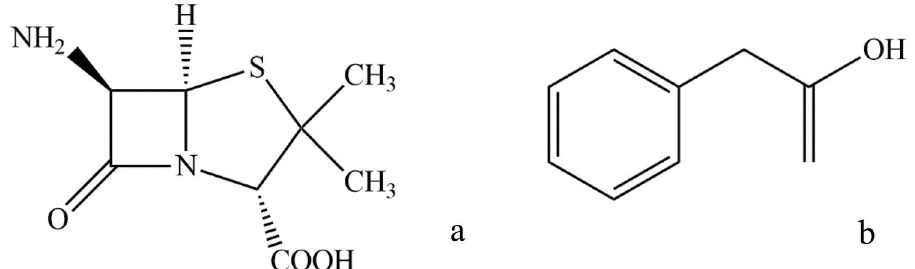
Figure 1. Structure of: ( a ) 6-aminopenicillanic acid ( b ) Phenyl acetic